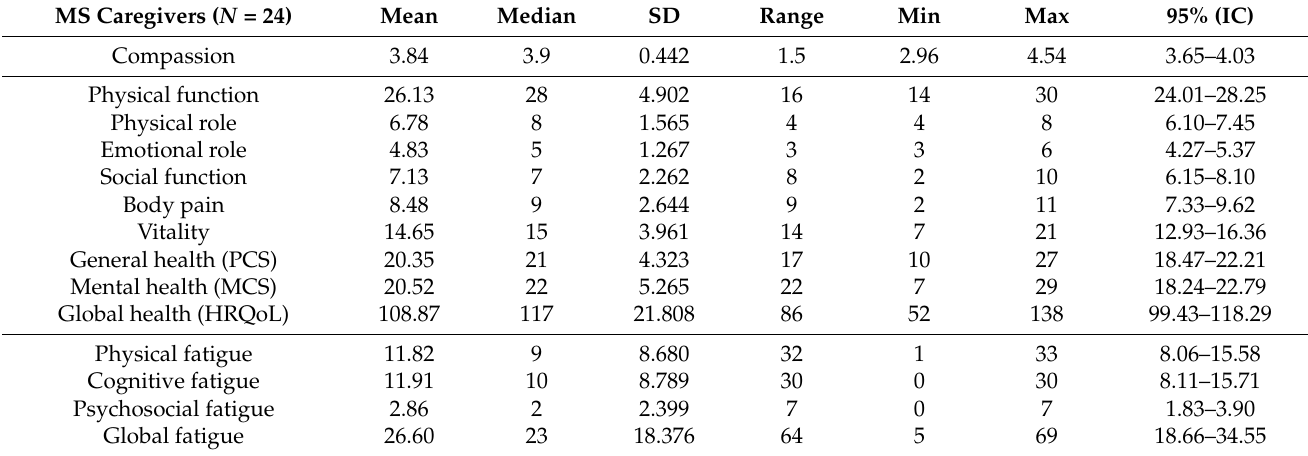
Table 3. Descriptive statistics of compassion, health, and fatigue variables in MS caregivers.